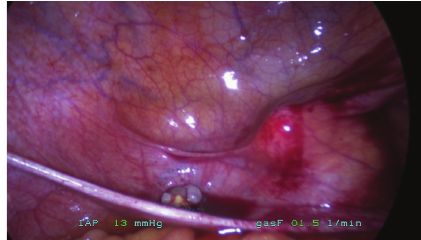
Figure 4: Mature teratoma.